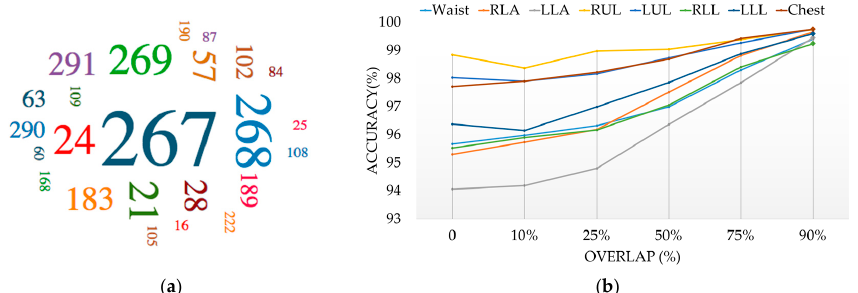
Figure 9. ( a ) Overall view of the non-dominated classifiers (classifier ID) and their power in providing high recognition accuracy ( b ) recognition system capabilities for diverse overlap values.